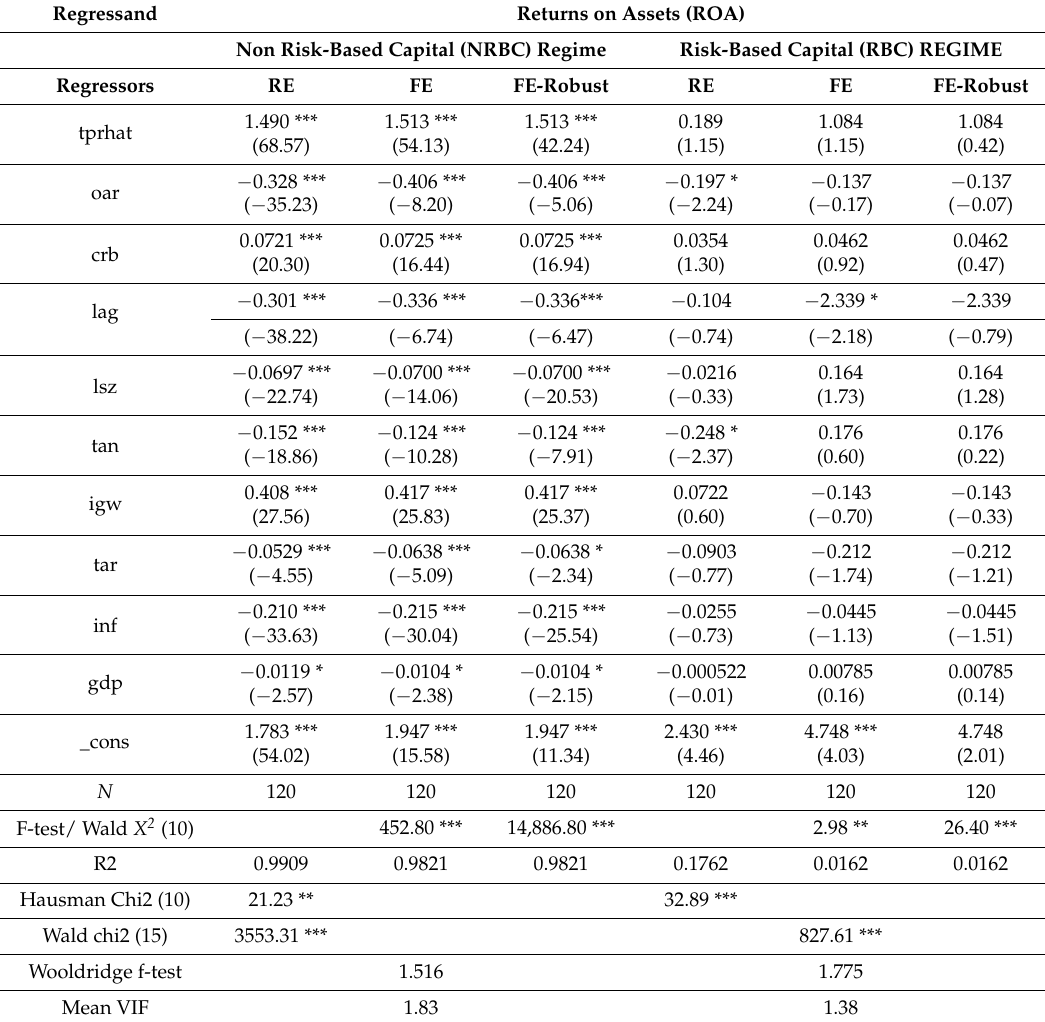
Table 7. TPR and ROA regression result for NRBC and RBC